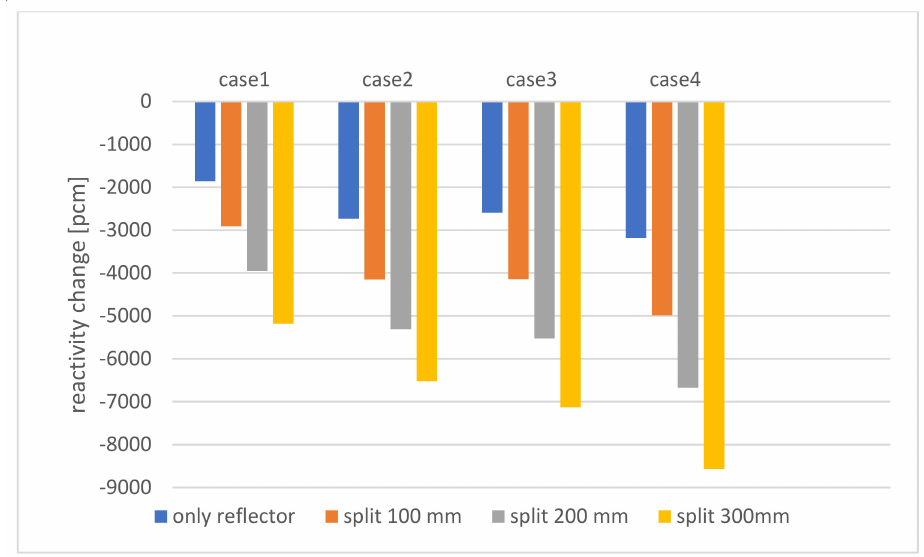
Figure 7. Negative reactivity effect (shutdown reactivity) caused by moving the reflector and different sized layers of the core away from the main core for the 4 described